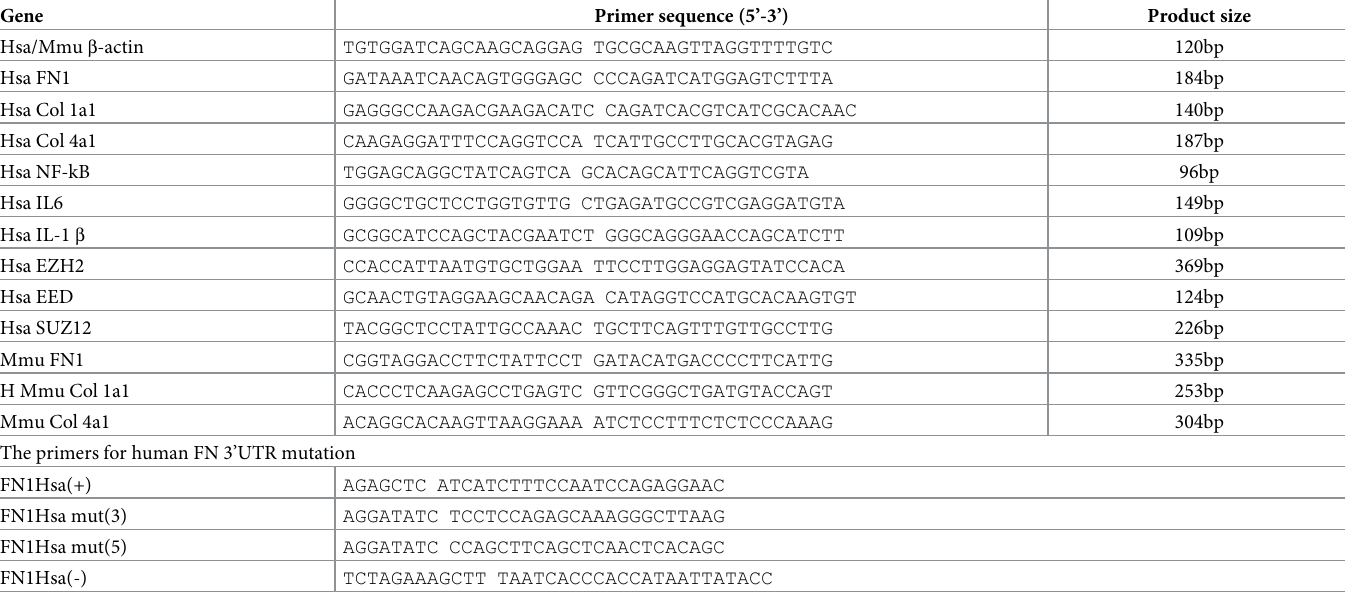
Table 1. The primers for the